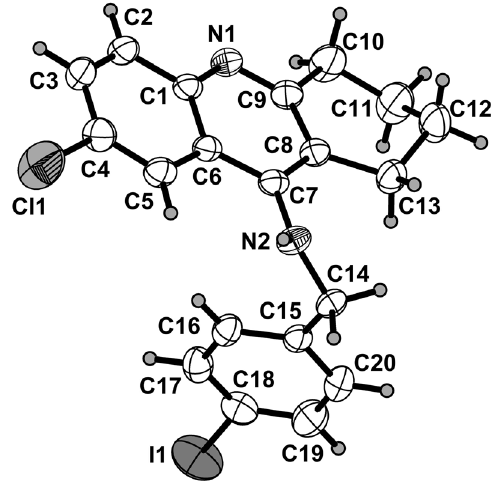
Table  : Data collection and